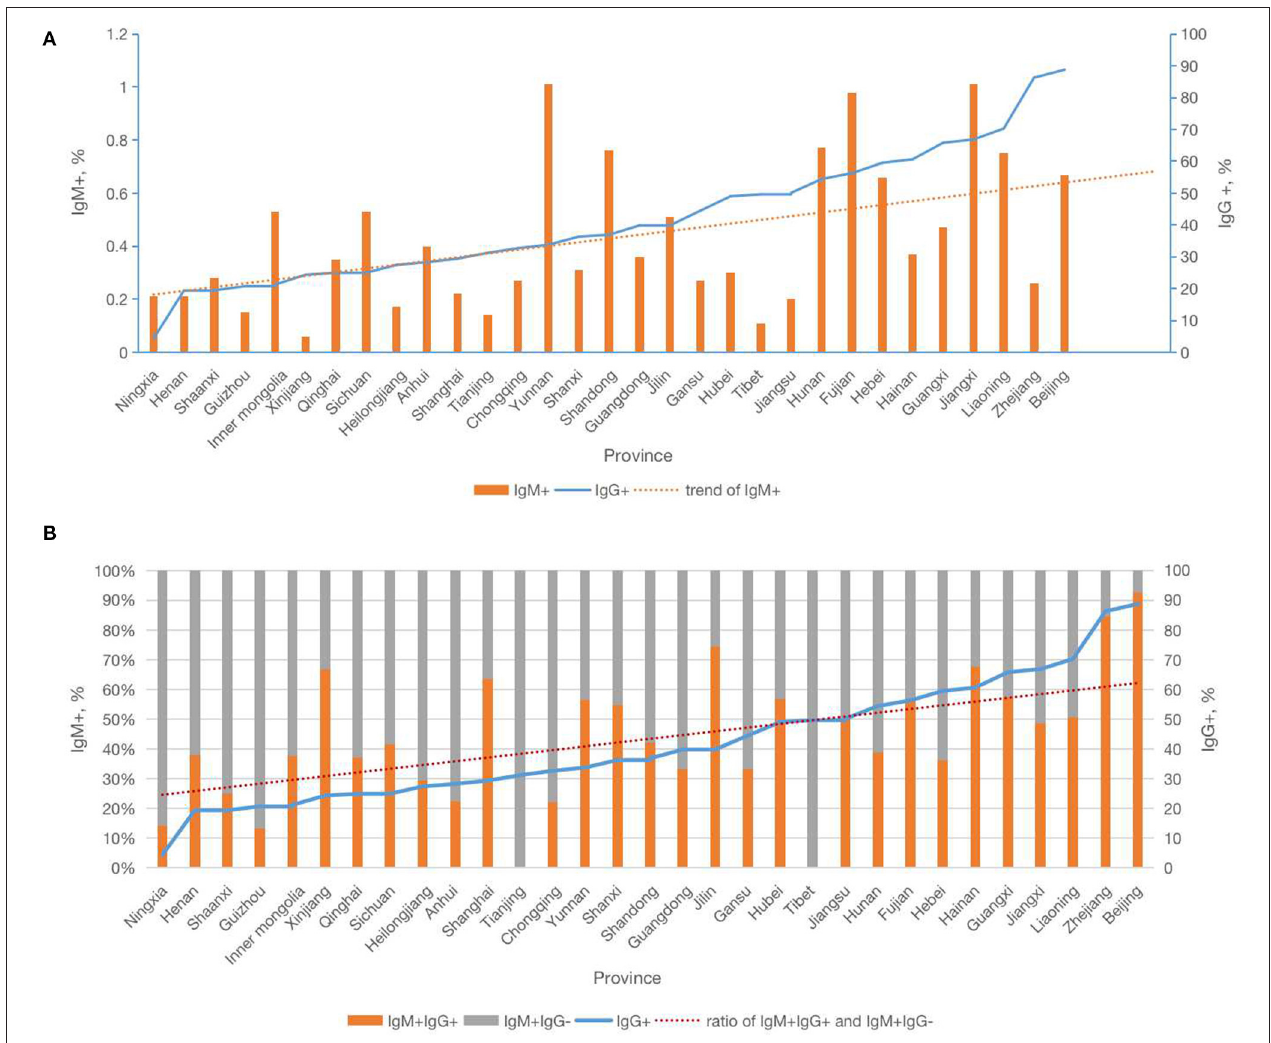
FIGURE 2 | Relationship of Cytomegalovirus IgG and IgM serology by provinces in China. (A) The relationship of Cytomegalovirus IgM + and trend of IgM + with IgG + by provinces in China. (B) The relationship of Cytomegalovirus IgM + IgG + with trend of IgG + and ratio of IgM + IgG + and IgM + IgG − by provinces in